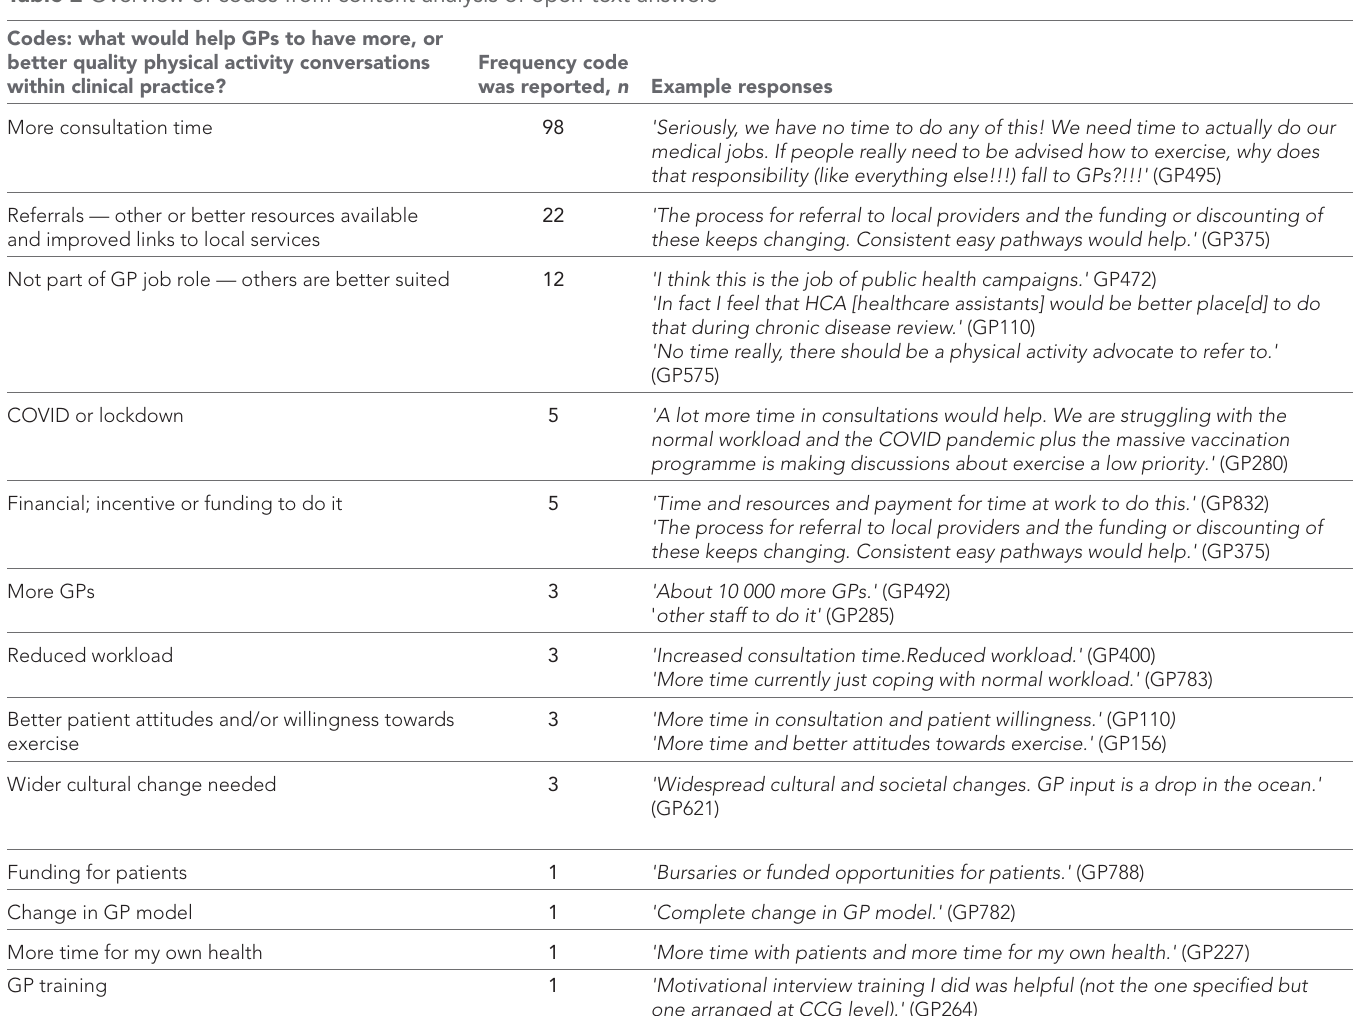
Frequency code was reported, n Example responses